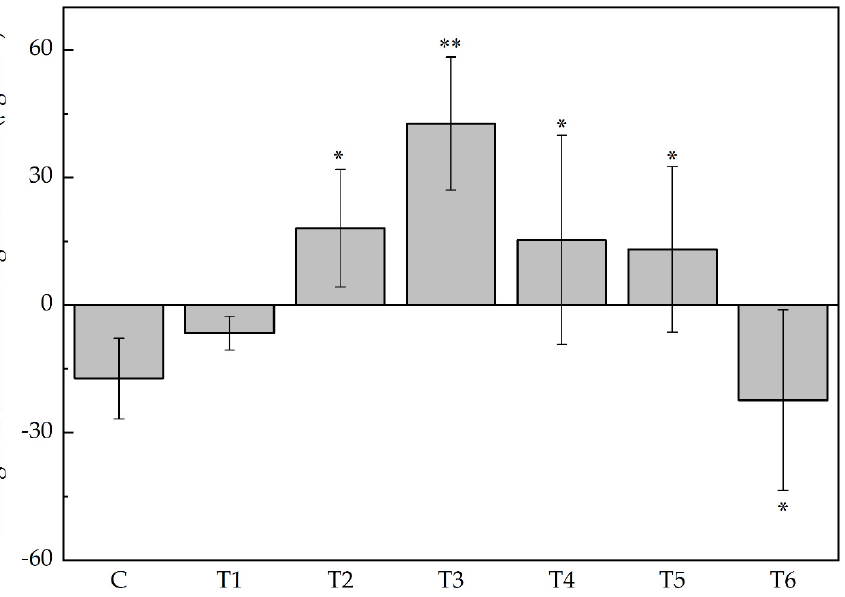
Figure 3. Changes in the filamentous algal biomass. Abbreviations for groups are the same as in Figure 1. Stars above the histogram show significant difference between control group and treat- ment groups (* p < 0.05, ** p < 0.01).